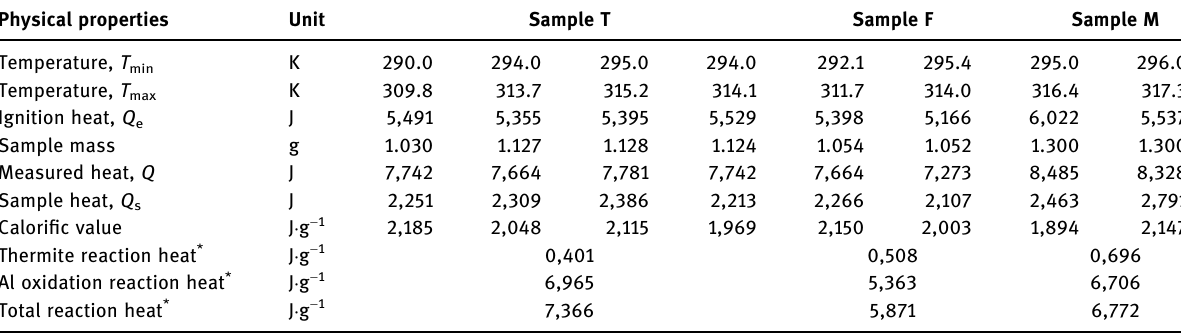
Table 2: Calorimetry results and calori fi c values calculated from aluminum and iron oxide